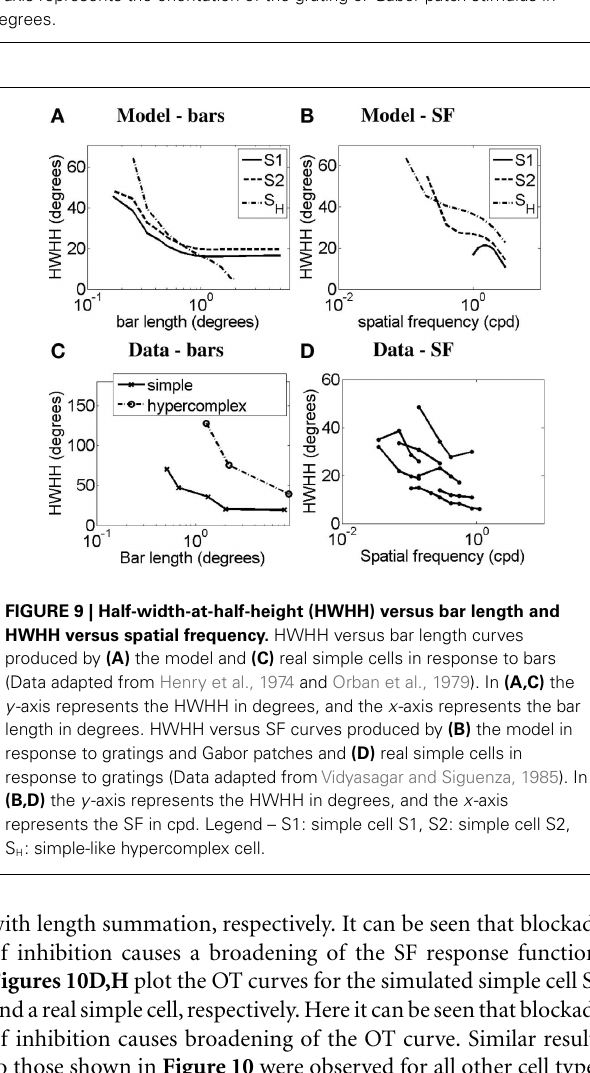
FIGURE 8 | Orientation-tuning curves of (A) the simulated simple cell S2 and (C) a real simple cell with length summation (data adapted from Vidyasagar and Siguenza, 1985) in response to gratings of different SFs. (B) OT curves of the simulated simple-like hypercomplex cell in response to